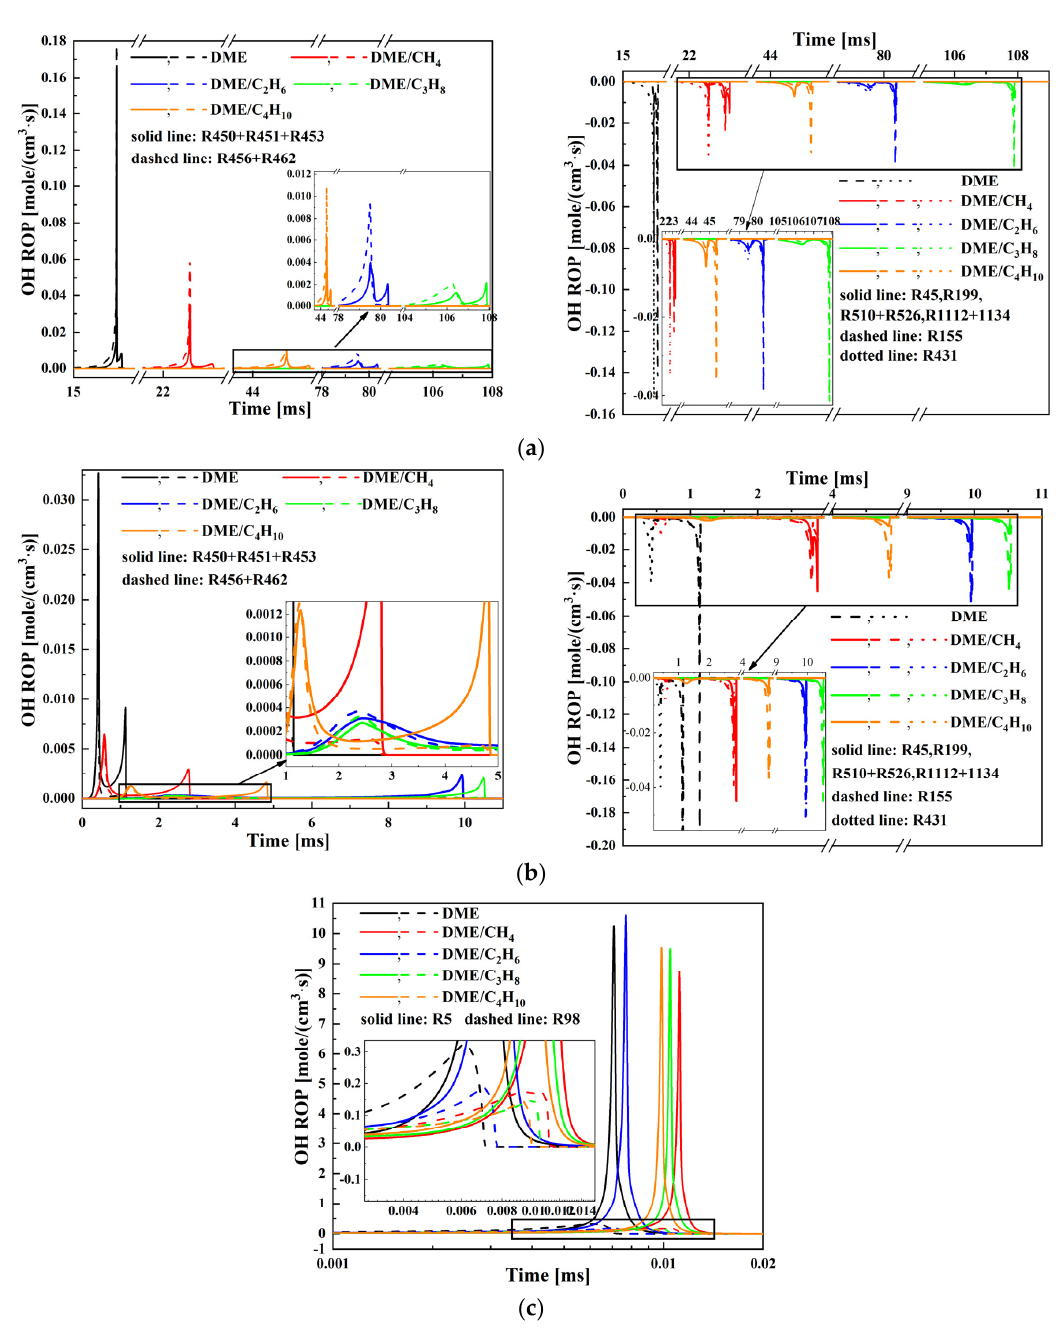
Figure 9. Production rate of OH radicals of the important elementary reactions for various compressed temperatures at P c = 20 bar and φ = 0.5: ( a ) T c = 650 K; ( b ) T c = 800 K; and ( c ) T c = 1500 K. Table 2. Important elementary reactions involving OH radicals.